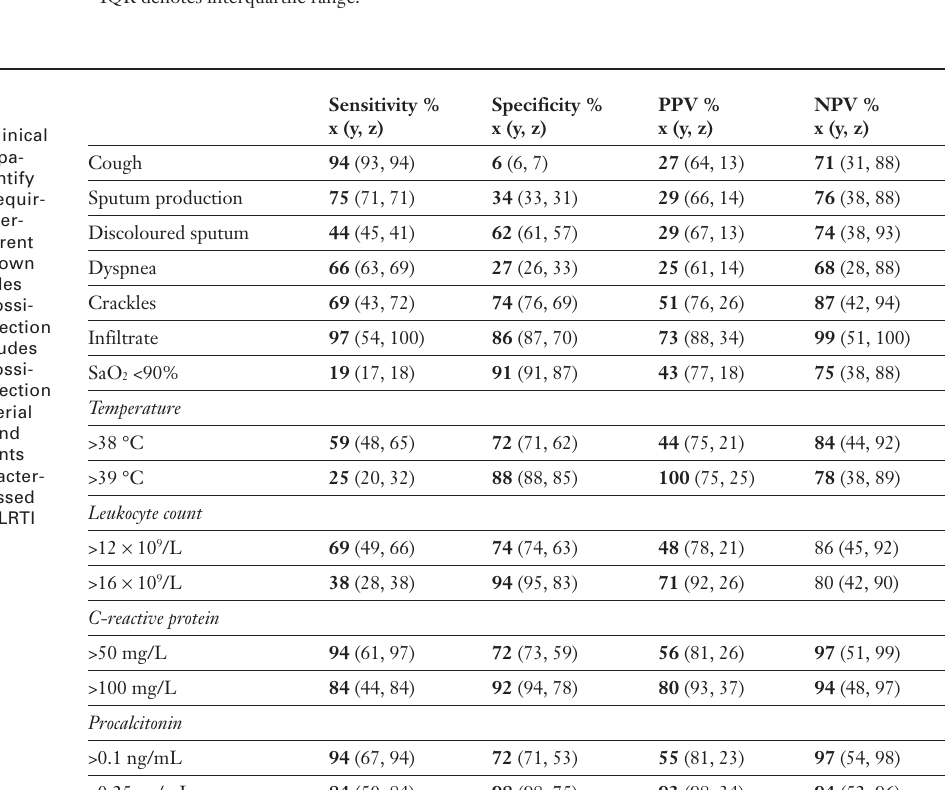
* PPV = positive predictive value, NPV = negative predictive value